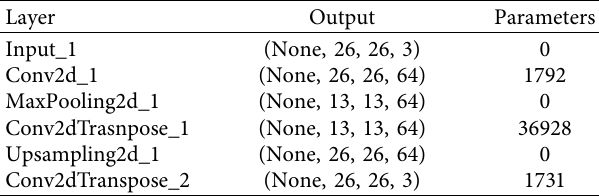
Table 1: Architecture details of convolutional